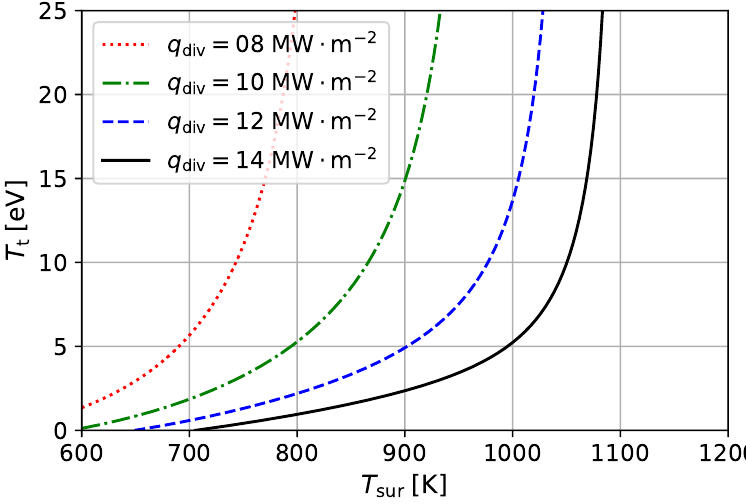
Figure 3. Temperature T t as a function of the target surface temperature T sur for different values q div